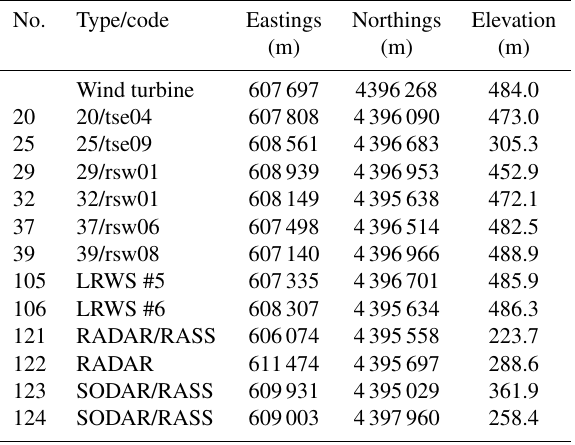
Table 1. Reference points as in Fig. 3 (ED50 UTM